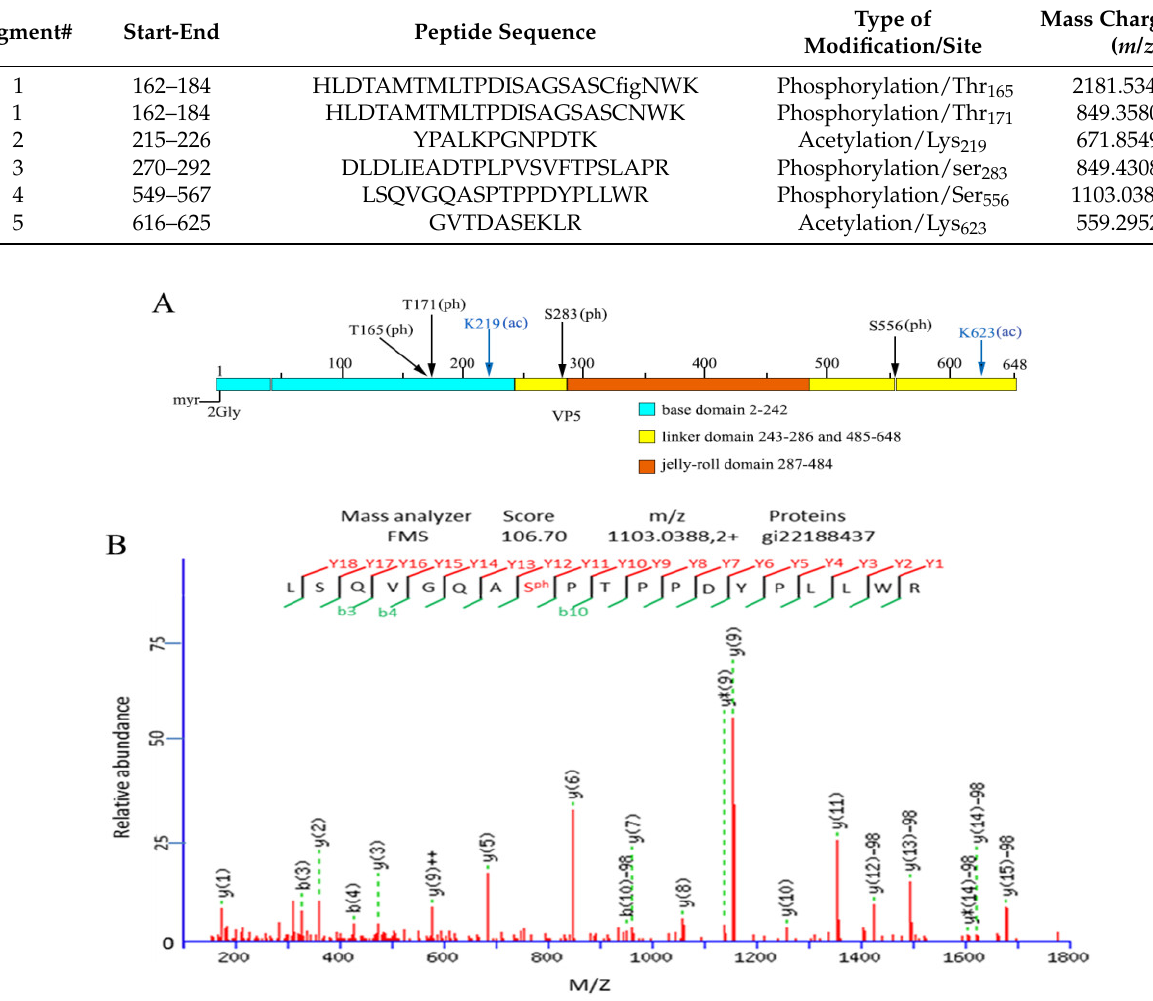
Figure 3. Analysis of phosphorylation and acetylation in VP5 tryptic peptide. ( A ) Diagrammatic representation of identified protein posttranslational modification sites in three different VP5 do- mains. ( B ) LC-MS/MS spectrum of a tryptic peptide ion Ser556 phosphorylated peptide LSQVGQAS556(ph)PTPPDYPLLWR. LC-MS/MS, liquid chromatography-tandem mass spectrometry.